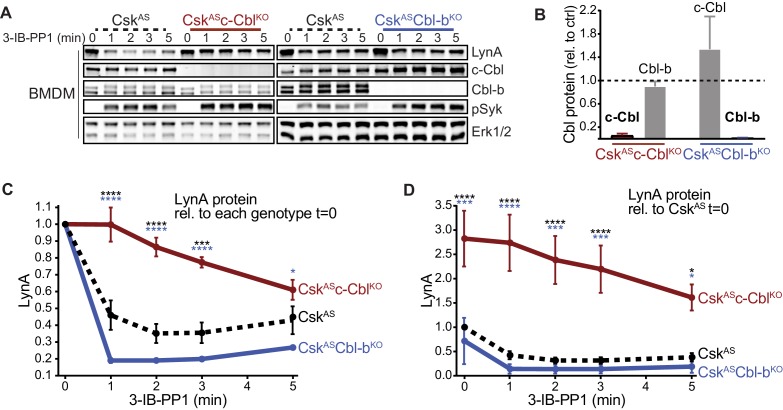
Loss of c-Cbl expression in macrophages leads to steady-state upregulation and delayed degradation of LynA protein.(A) Immunoblots showing LynA, c-Cbl, and Cbl-b protein in CskAS, CskASc-CblKO, and CskASCbl-bKO BMDMs treated with 3-IB-PP1 for the indicated times. Interdomain-B-phosphorylated SykpY352 (pSyk, Yan et al., 2013; Wang et al., 2010; Law et al., 1996), an SFK target and prerequisite for Syk activation, is shown as a control for 3-IB-PP1-initiated signaling; total Erk1/2 is shown as a loading control. (B–D) Densitometry quantification of relative levels of Cbl and LynA protein, corrected for total protein content using REVERT Total Protein Stain (TPS). (B) Quantification of c-Cbl (red) and Cbl-b (blue) in CskASc-CblKO and CskASCbl-bKO BMDMs relative (rel.) to their steady-state levels in CskAS BMDMs (dotted line). Expression of the other Cbl family member is shown in gray. Error bars reflect the standard error of the mean (SEM), n = 4 from three CskASCbl-/- mice and n = 3 from two CskASCblb-/- mice. (C–D) Quantification of LynA relative to the steady-state level in each genotype (C) or relative to the steady-state level in CskAS BMDMs (D). SEM, n = 8 for CskAS, n = 5 from three CskASCbl-/- mice, n = 3 from two CskASCblb-/- mice. The significance (Sig.) from two-way ANOVA (ANOVA2) with Tukey’s multiple comparison test (-Tukey) are as follows: [CskASc-CblKO vs. CskAS black asterisks], [CskASc-CblKO vs. CskASCbl-bKO, blue asterisks]; ****p<0.0001, ***p=0.0001–0.0005, * P=0.0171–0.0459. No significant difference was detected between other pairs (ns). Note: some of the error bars are smaller than the line width. Refer to Figure 1—source data 1. Paradoxical changes in Erk1/2 phosphorylation in Cbl-deficient cells are shown in Figure 1—figure supplement 1. Supporting siRNA studies are shown Figure 1—figure supplement 2.10.7554/eLife.46043.006Figure 1—source data 1.Quantification of Cbl and LynA proteins in BMDMs lacking c-Cbl or Cbl-b.